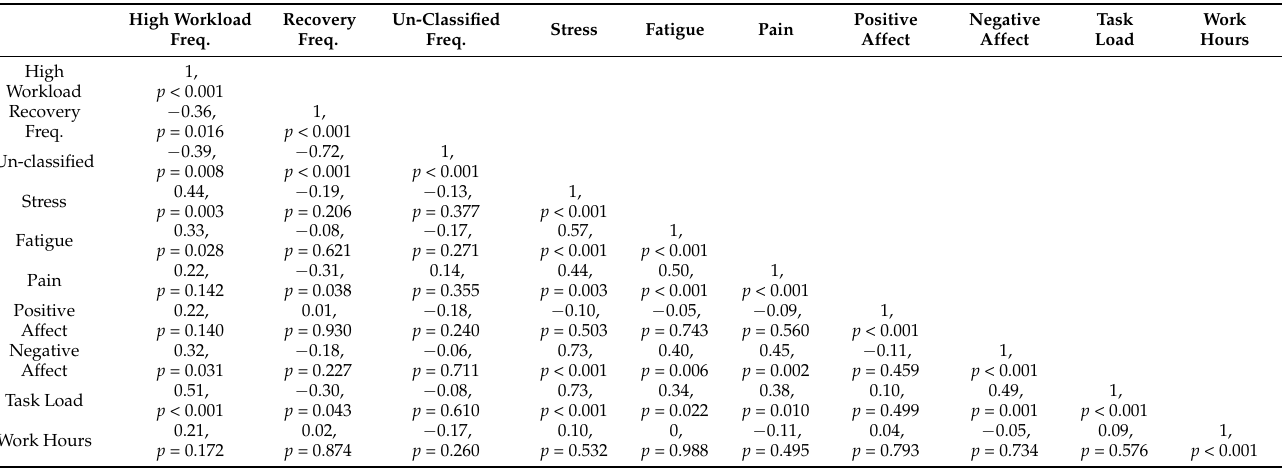
Table A1. Between-person intercorrelation matrix.